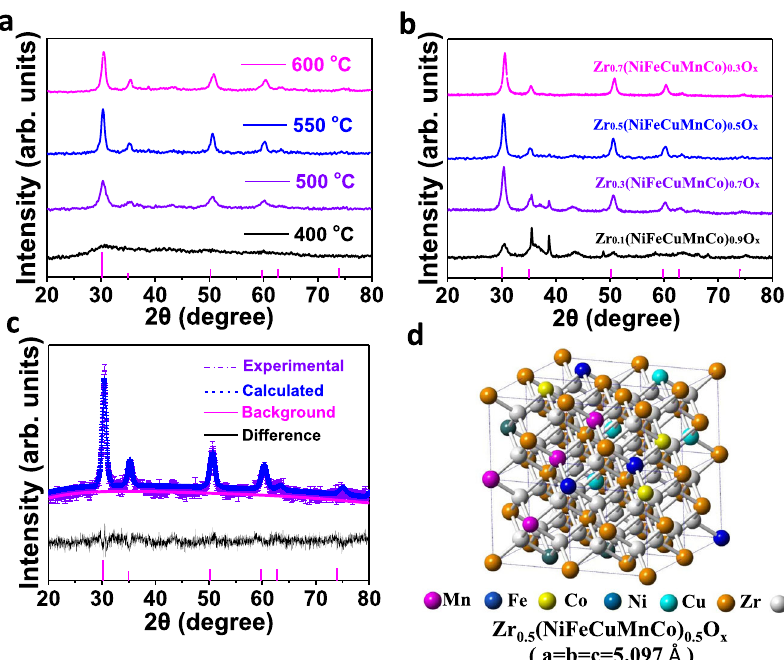
Fig. 3 The synthesis of a cubic phase Zr 0.5 (NiFeCuMnCo) 0.5 O x . a The phase evolution of Zr 0.5 (NiFeCuMnCo) 0.5 O x precursors under different calcination temperatures. b The P-XRD patterns of ZrO 2 doped with different total ratio (0.3 – 0.9) of fi ve metals. c P-XRD patterns together with Rietveld fi ts of the Zr 0.5 (NiFeCuMnCo) 0.5 O x sample prepared at 550 °C. d Structural view of cubic Zr 0.5 (NiFeCuMnCo) 0.5 O x . arb. units: arbitrary